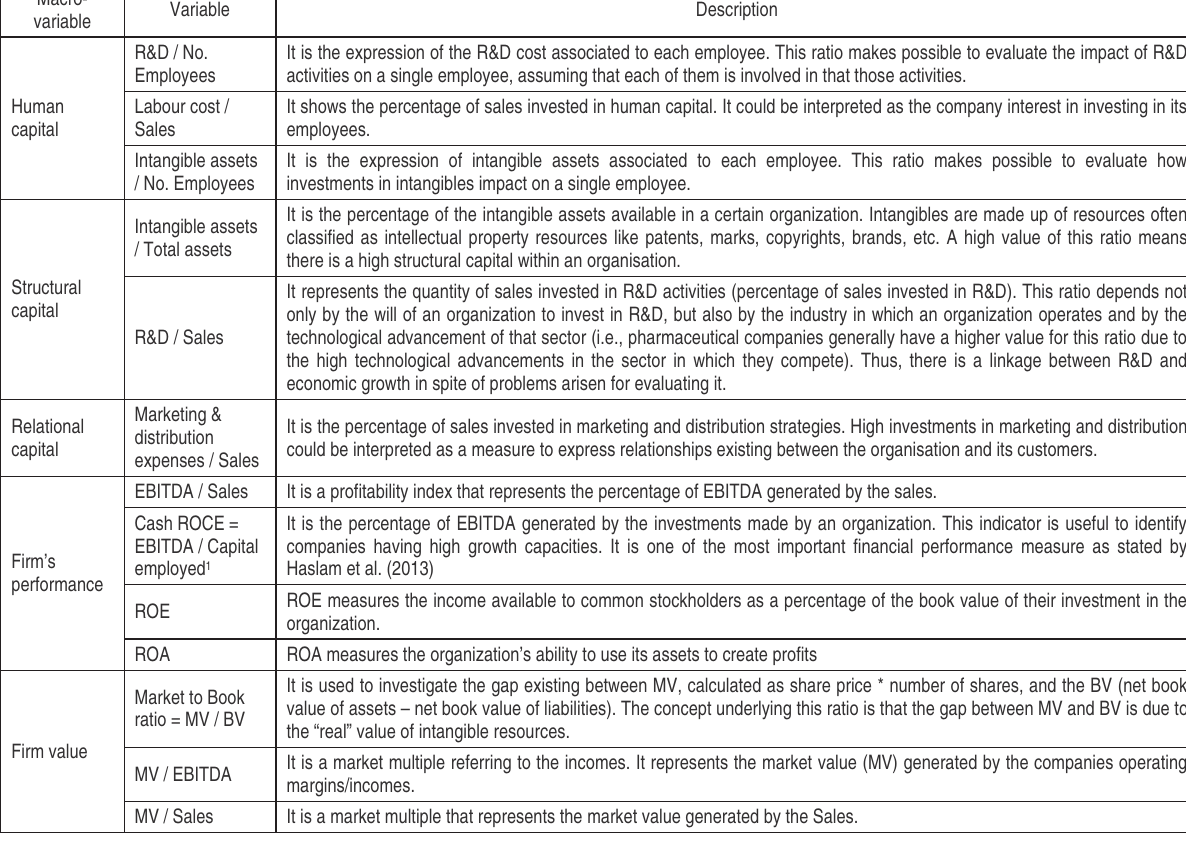
Table 2. Intellectual capital and financial variables